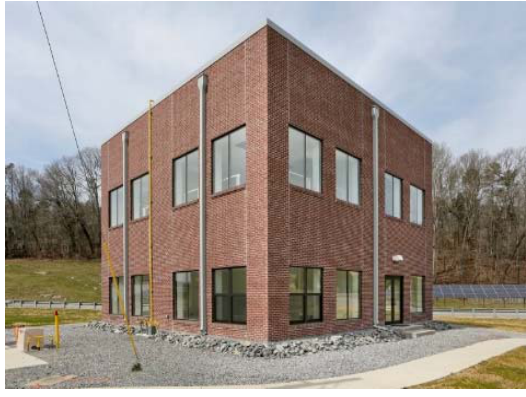
Figure 6. Test Building. Table 5. Target building and system characteristics.